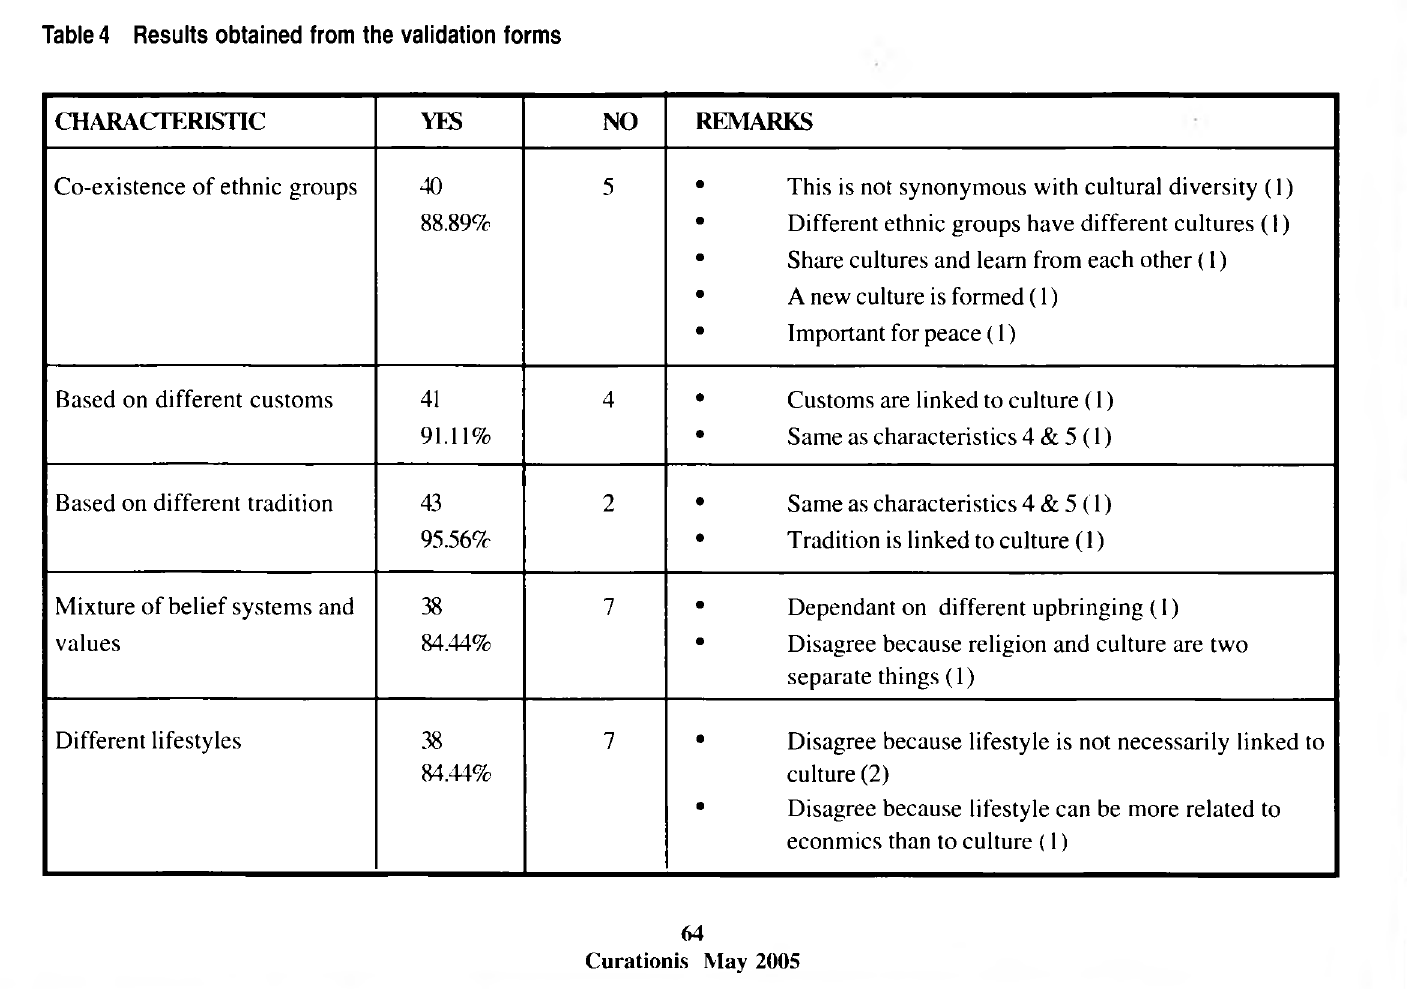
Table 4 Results obtained from the validation